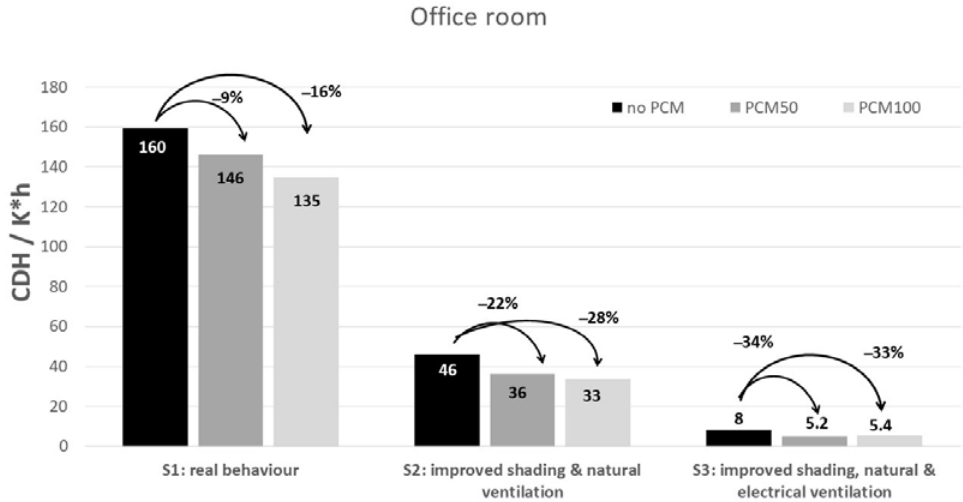
Figure 9. Effect of PCM on periods of discomfort within office room from July through September.